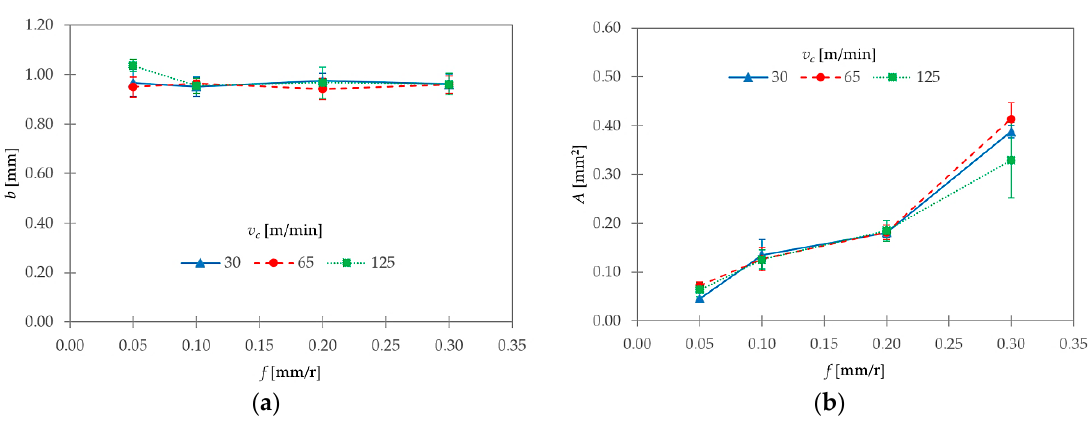
Figure 14. ( a ) Chip width ( b v ) and ( b ) chip transverse area ( A ) as a function of v c and f .